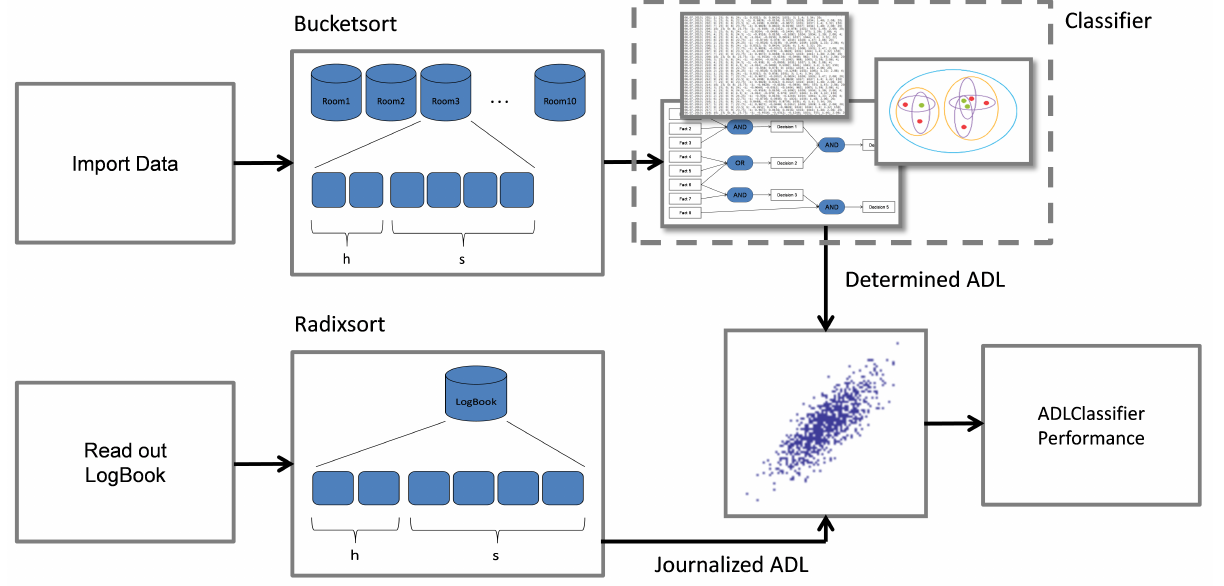
Figure 6. Correlation of the ADL classifier output with the ADL